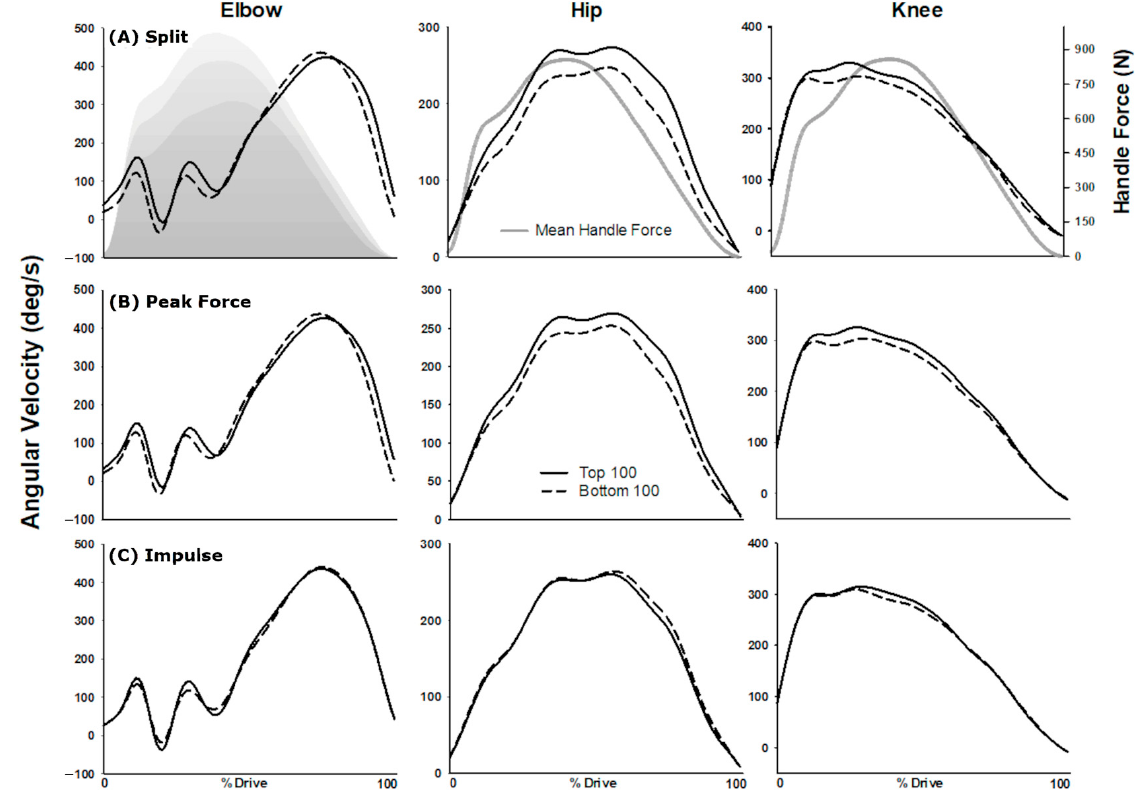
Figure 6. Kinematic patterns for the elbow, hip and knee, reconstructed from the top (solid) and bottom (dashed) 100 strokes for: ( A ) split (PC 1,2,6); ( B ) peak force (PC 1,6,7); and ( C ) impulse (PC 3,4,5,6). Overlaid (solid grey) the elbow split reconstructions is the mean handle force, along with top 100 (light grey) and bottom 100 (dark grey) for all rowing strokes. Mean handle force (grey line) overlaid hip and knee for split reconstruction.